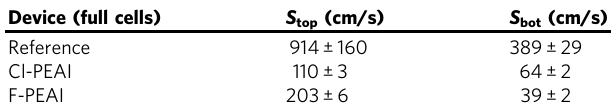
Table 2 Top and bottom fi tted interface recombination velocity for reference and A-cations full cells.